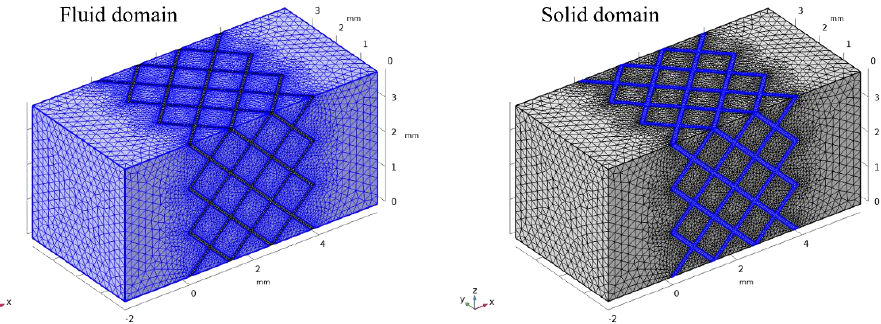
Figure 3. Representation of a free tetrahedral mesh applied to fluid and solid domains.